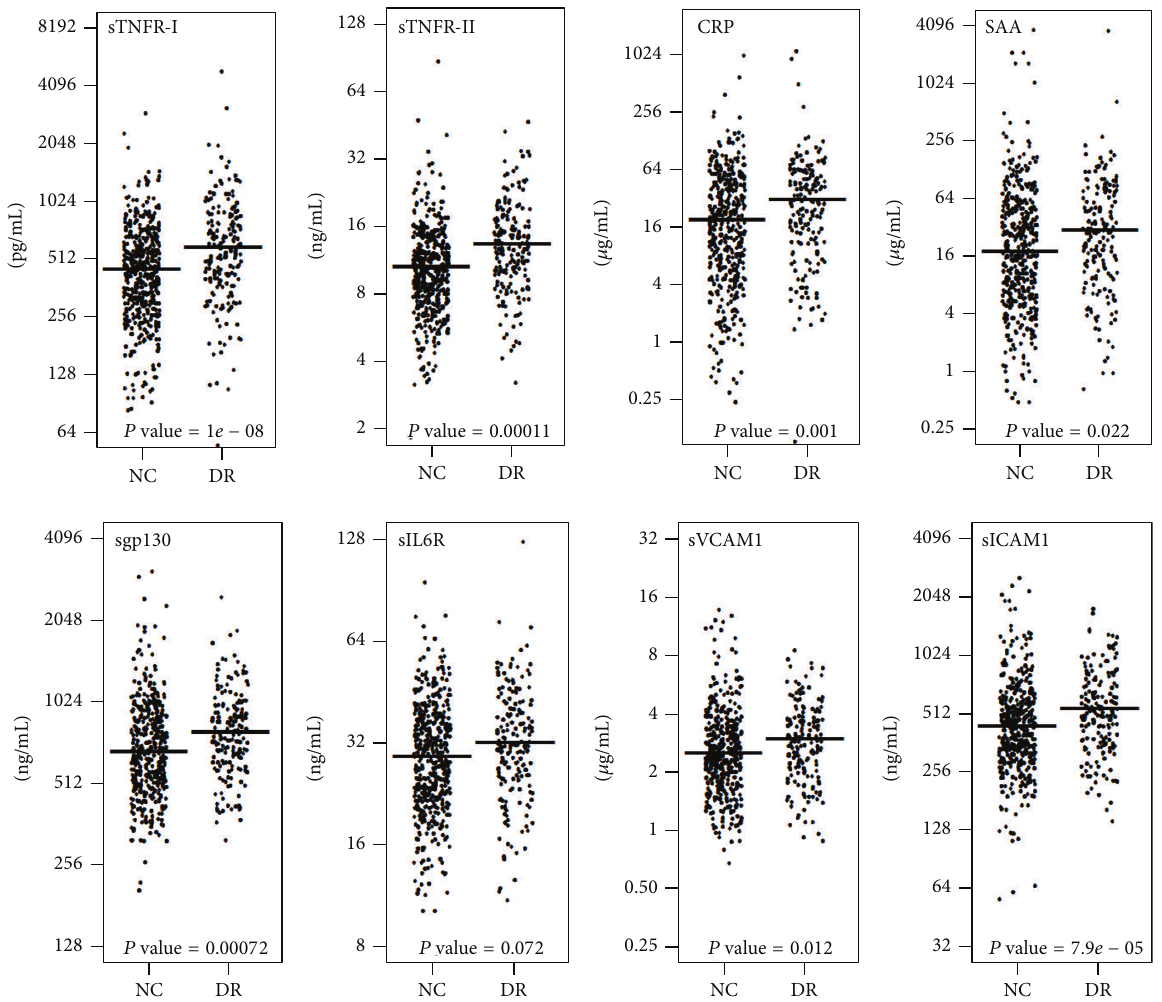
Figure 1: Elevated serum protein levels in T1D subjects with DR. Serum levels of eight proteins were measured in 678 T1D subjects aged 20–75 years. Comparisons were made between 482 T1D patients with no complications and 196 T1D patients with diabetic retinopathy. Plots depict the distribution of the protein levels in two different